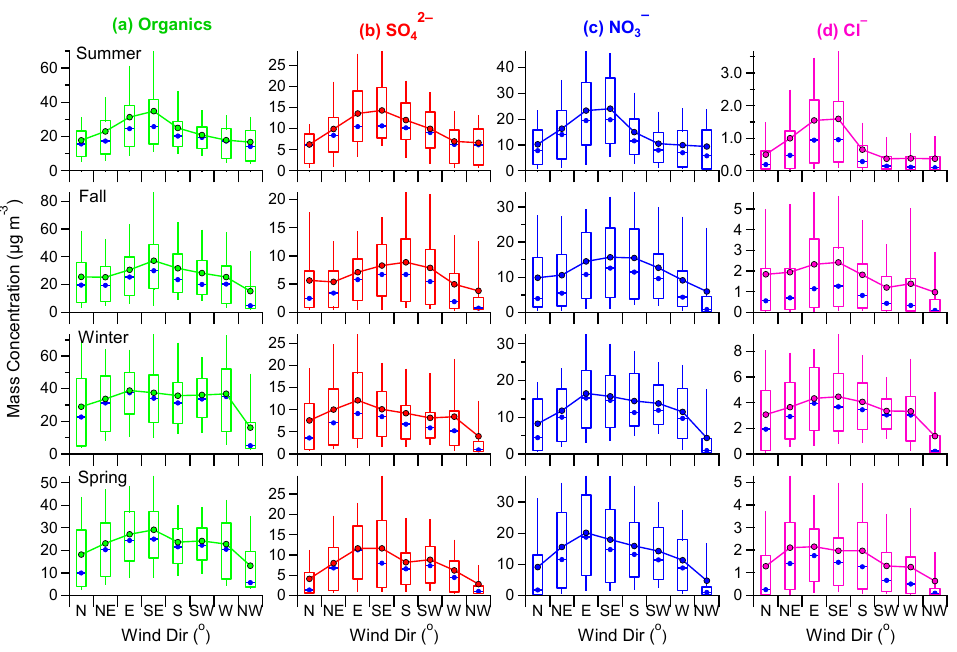
Figure 11. Box plots of mass concentrations of (a) organics, (b) SO 2 − All the data were segregated into eight wind sectors representing north (N), northeast (NE), east (E), southeast (SE), south (S), southwest (SW), west (W), and northwest (NW). The mean (cross), median (horizontal line), 25th and 75th percentiles (lower and upper box), and 10th and 90th percentiles (lower and upper whiskers) are